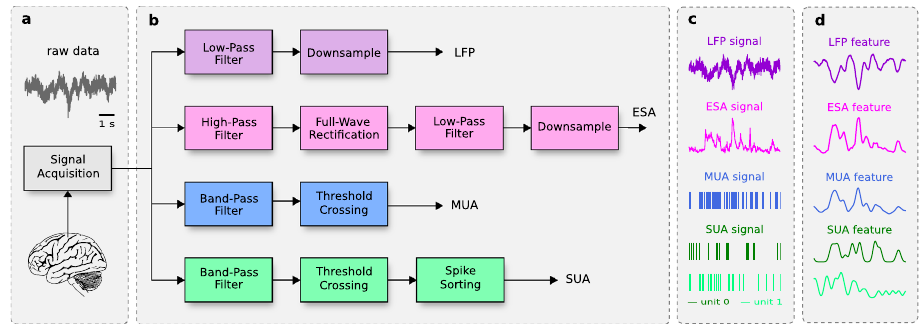
Figure 7. Schematic illustration of signal processing and feature extraction steps. ( a ) Raw neural signal acquisition from the motor cortex area of monkeys with a 96-channel intracortical Utah array. ( b ) Signal processing steps for different types of neural signals (LFP, ESA, MUA, and SUA). ( c ) LFP, ESA, MUA, and SUA signals obtained from the processing steps. ( d ) Extracted features from LFP, ESA, MUA, and SUA